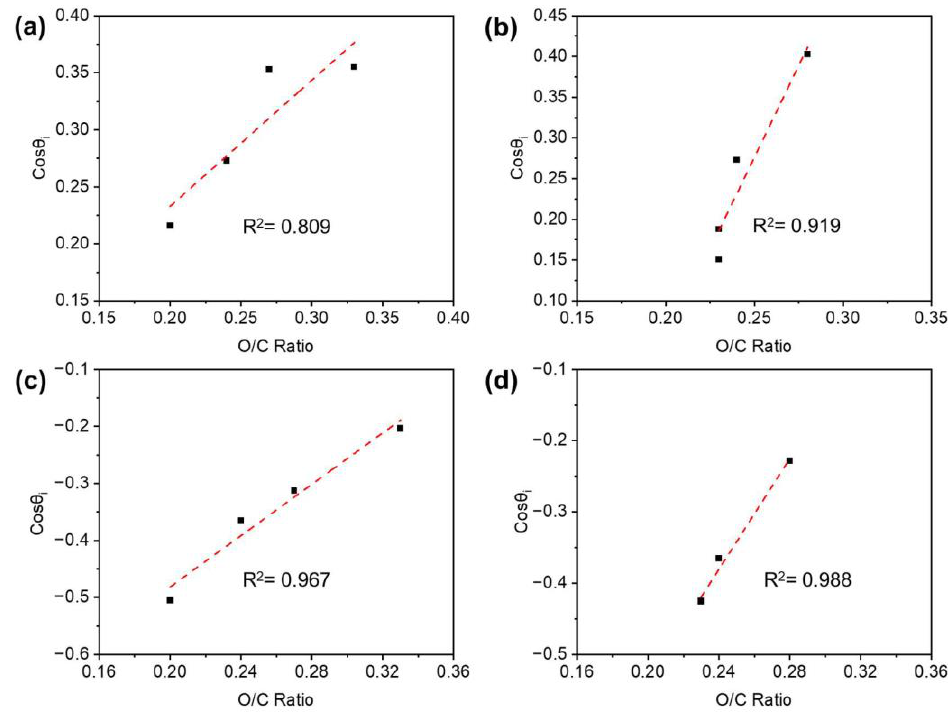
Figure 9. Relationship between initial wettability tested by water and the O/C ratio of the TPM- treated veneer with different temperatures ( a ) and durations ( b ), and tested by PF resin and the O/C ratio of the TPM-treated veneer with different temperatures ( c ) and durations ( d ).